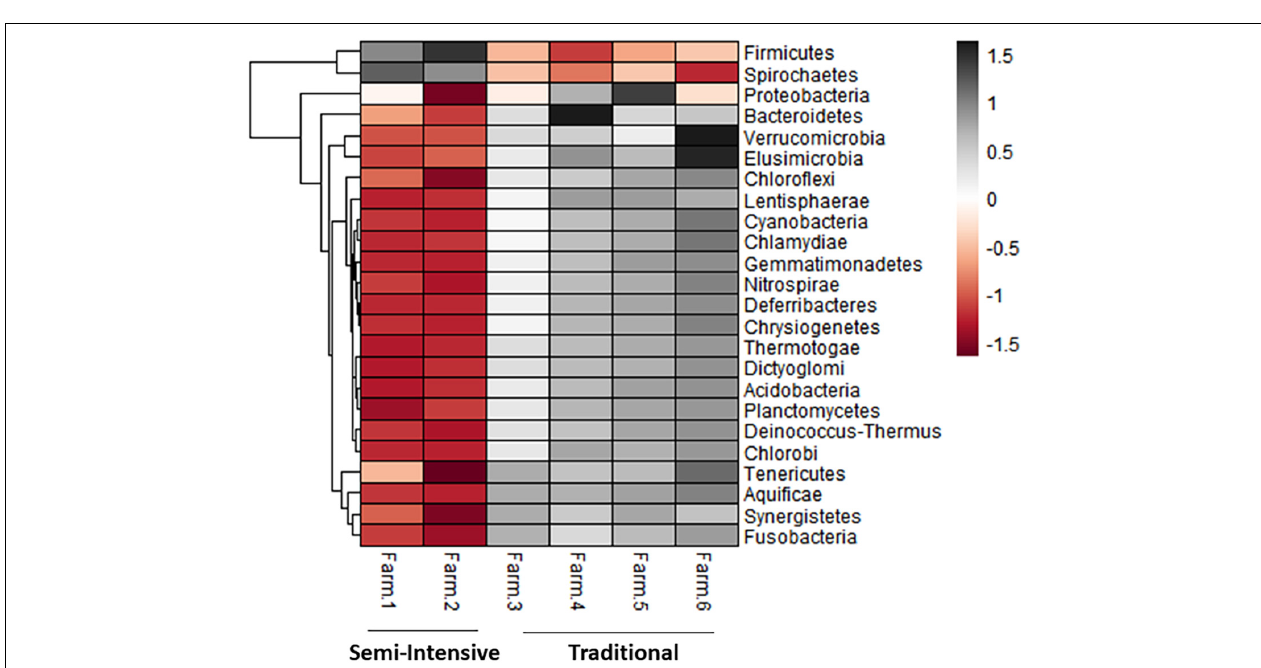
FIGURE 3 | Spearman correlation between bacterial diversity (Shanon index) and fecal parameters ( P < 0.05) constructed using the R package “corrplot.” (A) Arsenic, (B) Zinc, (C) Lead, (D) Phosphorous, (E) Nitrogen, and (F) Carbon.